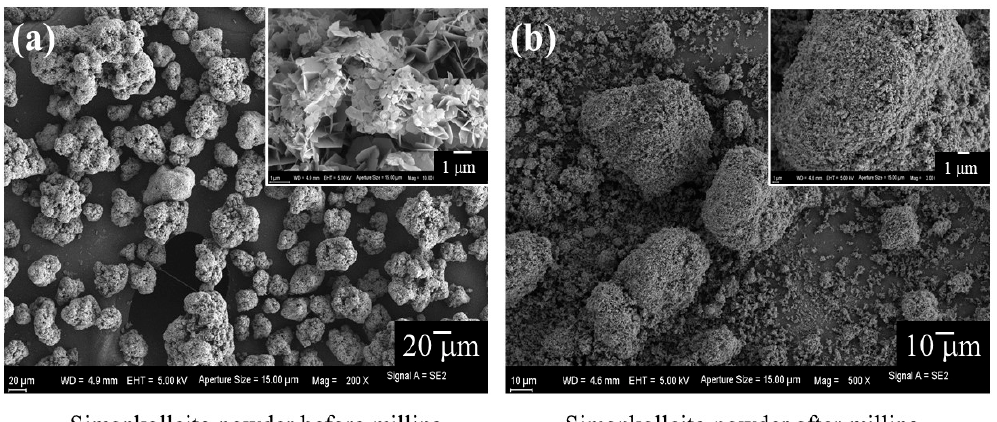
Figure 3. The SEM micrographs of the simonkolleite powder before ( a ) and after ( b )